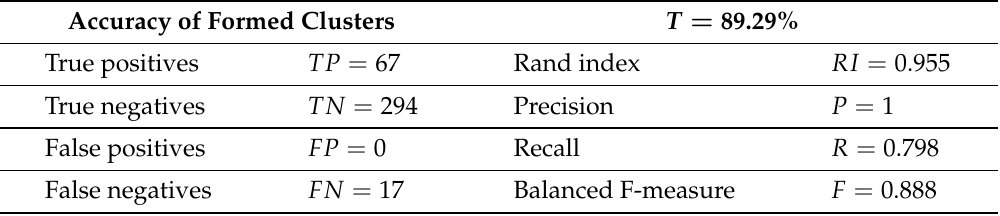
Table 6. Evaluation of clustering results obtained by IBC1 algorithm using RealWorld data